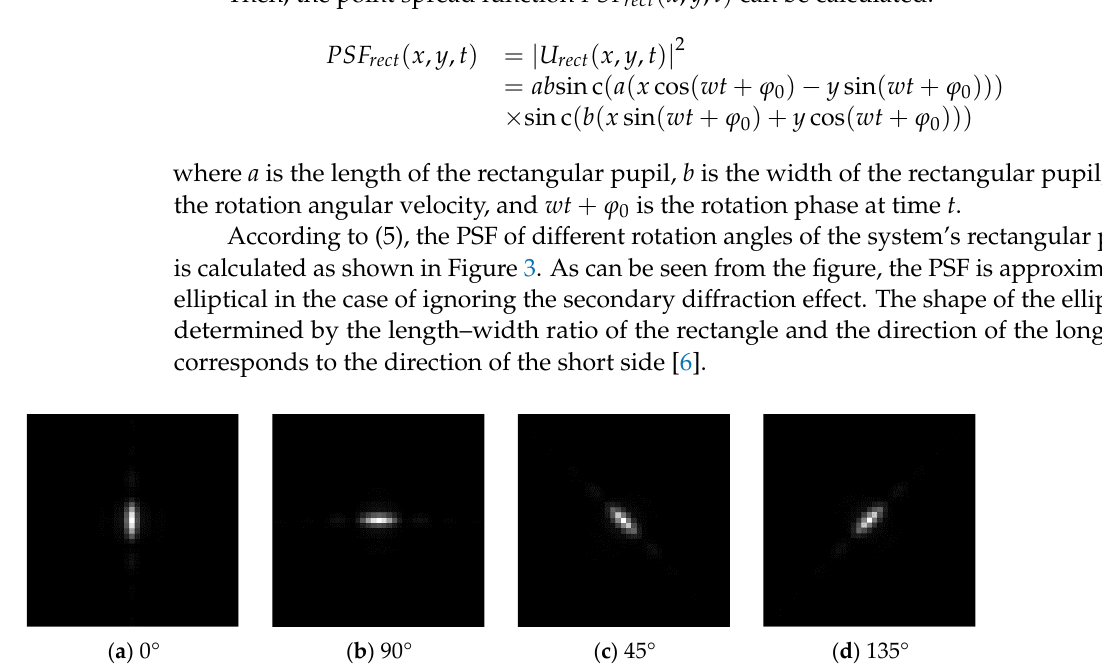
Figure 3. ( a – d ) Point spread function (PSF) with different rotation angles.